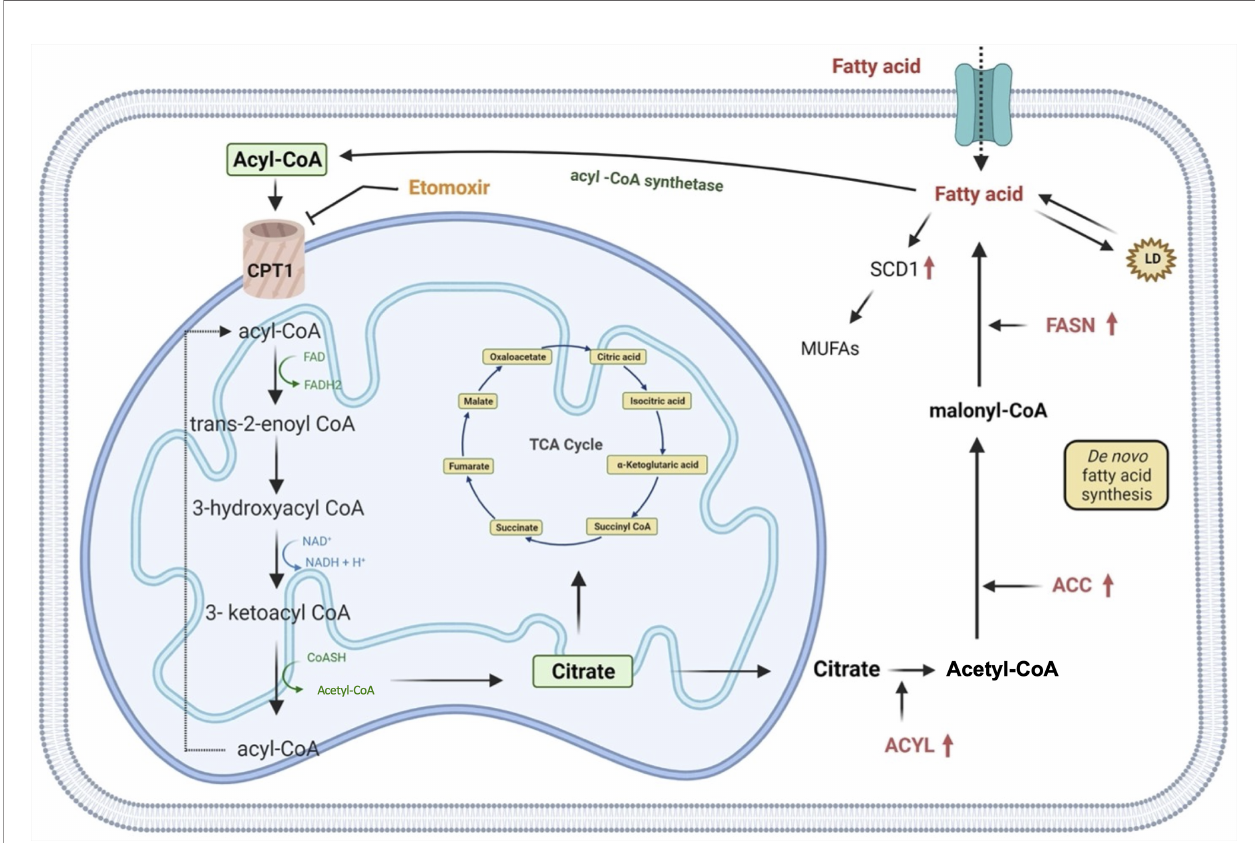
FIGURE 3 | Representation of lipid metabolism. Rewiring of lipid metabolism including increased lipid uptake, lipid desaturation, de novo lipogenesis, lipolysis and FAO is necessary for supply GCSCs with energy. Extracellular FFAs are transported into cells and catabolized in mitochondria to produce acetyl-CoA which is converted in citrate and it enters in TCA cycle for the oxidation. Alternatively, de novo fatty acids synthesis begins with acetyl-CoA that is converted in malonyl-CoA and then in palmitate. Lipid catabolism can even occur through fatty acids esteri fi cation that allow them to be stored as triglycerides in lipid droplets. In addition, saturated fatty acids can also be converted into mono-unsaturated fatty acids by SCD1, an enzyme upregulated in gastric cancer. ACC, acetyl-CoA carboxylase; ACYL, ATP citrate lyase; FASN, fatty acid synthase; MUFAs, mono-unsaturated fatty acids; SCD1, stearoyl-CoA desaturase 1; CPT1, carnitine palmitoyltransferase 1; TCA, cycle, tricarboxylic acid cycle; LD, lipid